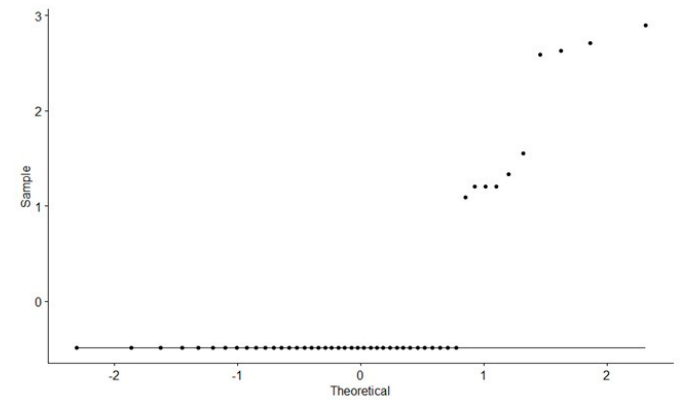
Figure 17. Normal probability plot of the control chart of deficiency 12.